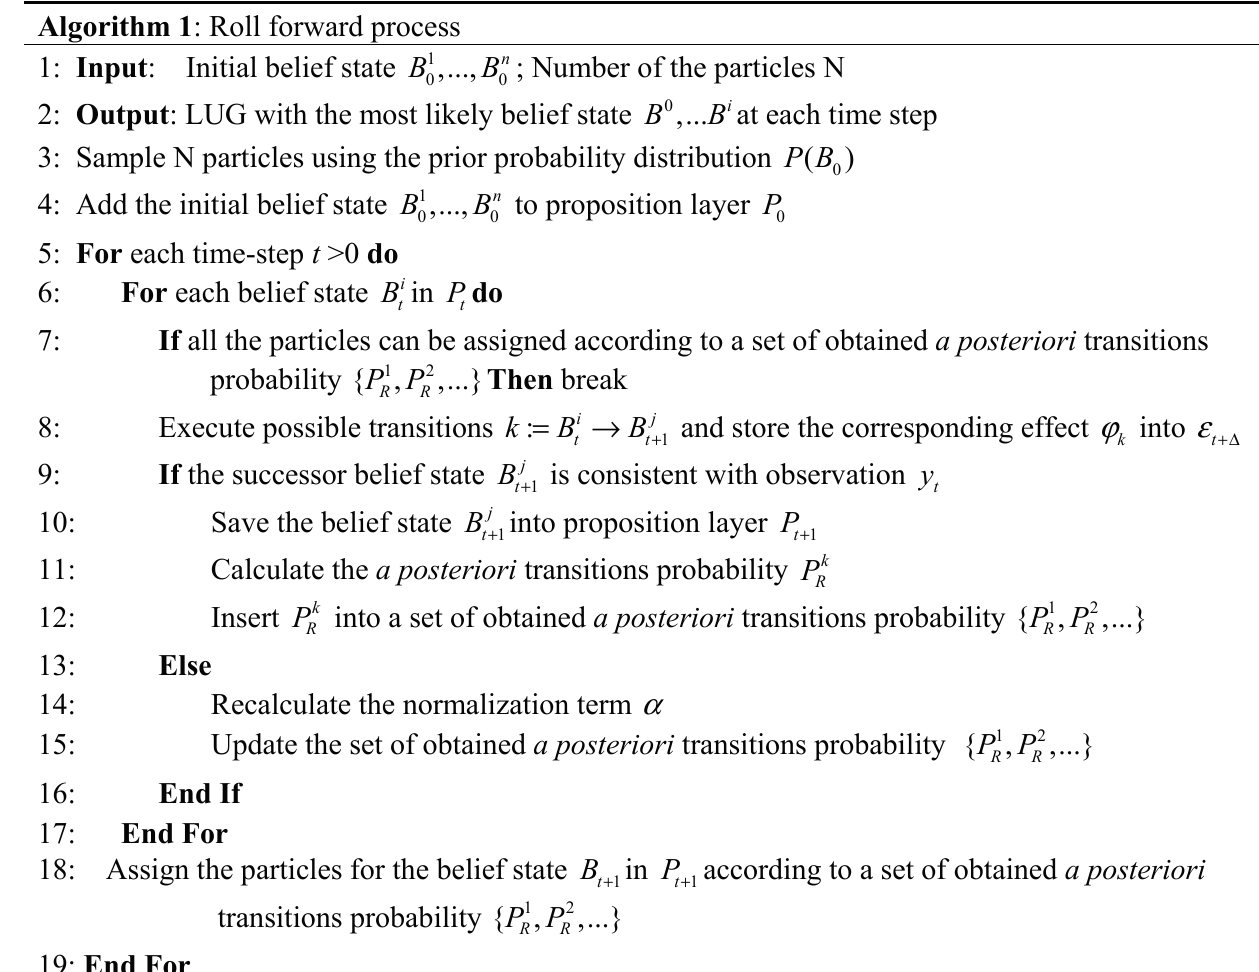
Algorithm 2 : Roll back process Label uncertainty graph